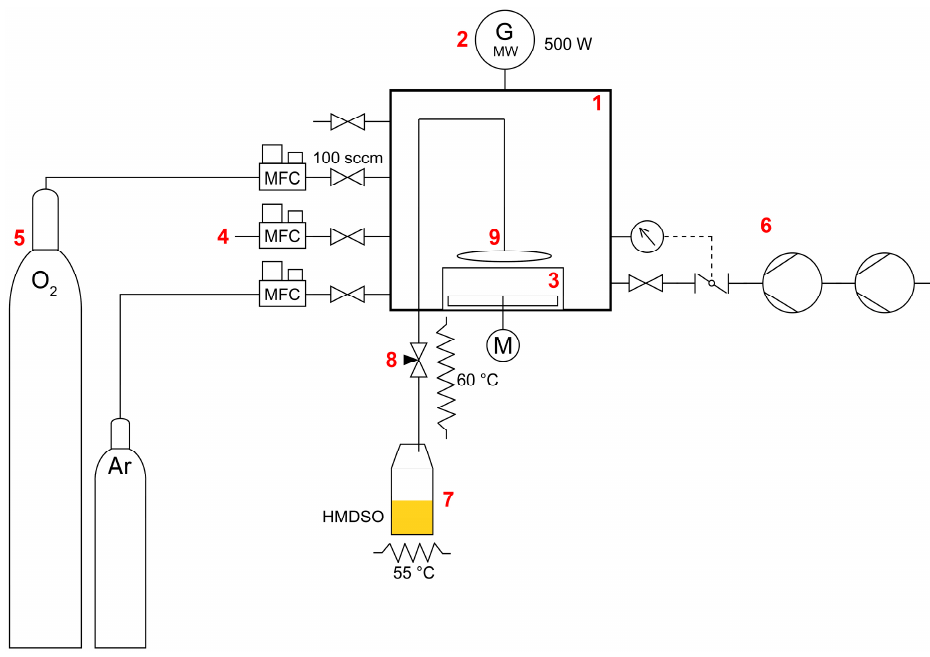
Figure 1. Scheme of used experimental setup: ( 1 ) vacuum chamber; ( 2 ) microwave power supply;